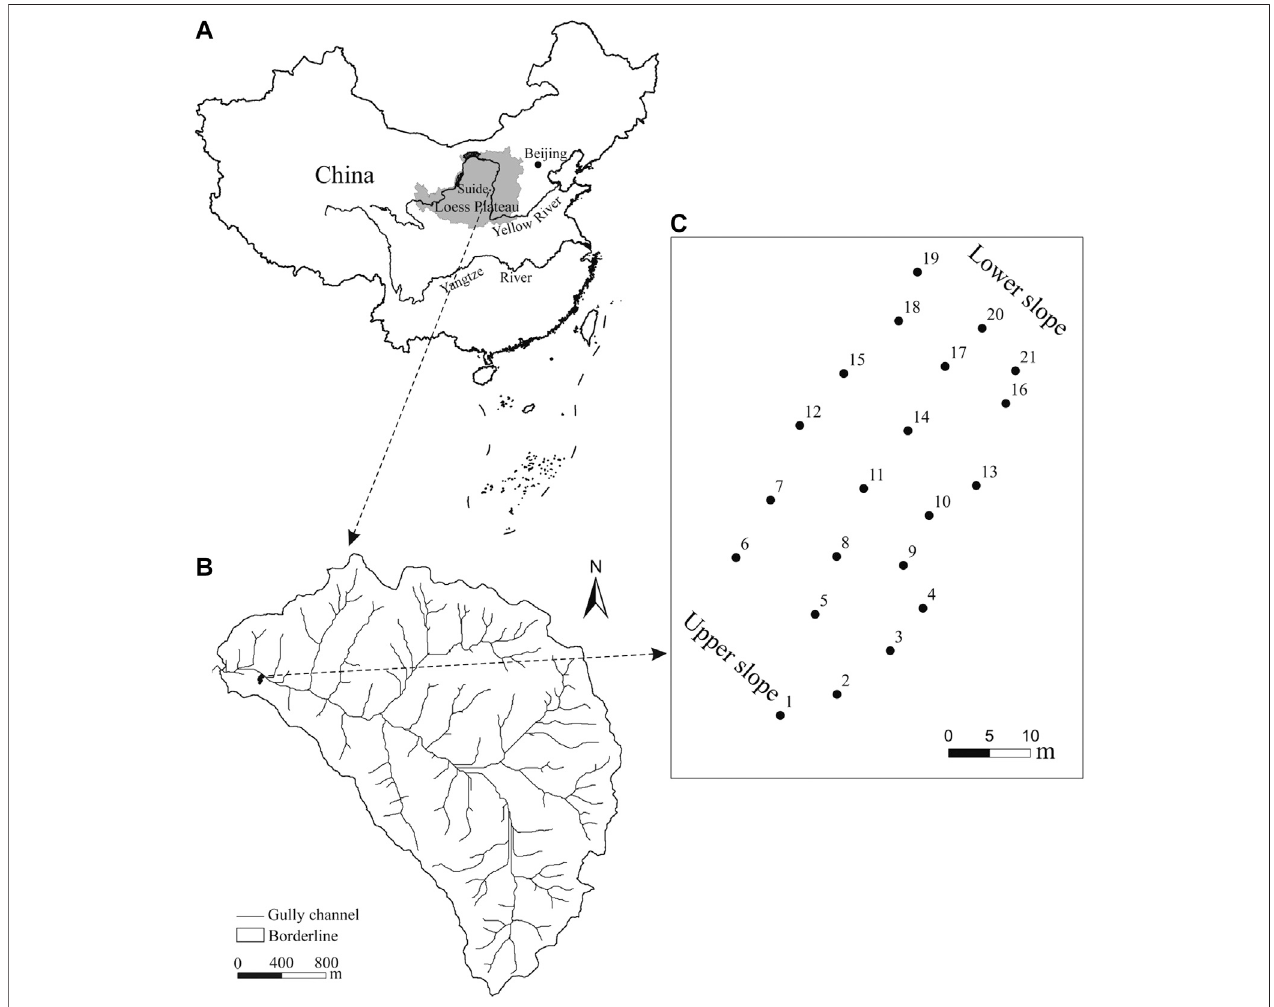
FIGURE 1 | The distribution of the 21 tube locations across the hillslope (C) located in the Wangmaogou watershed (B) on the Loess Plateau, China (A) .